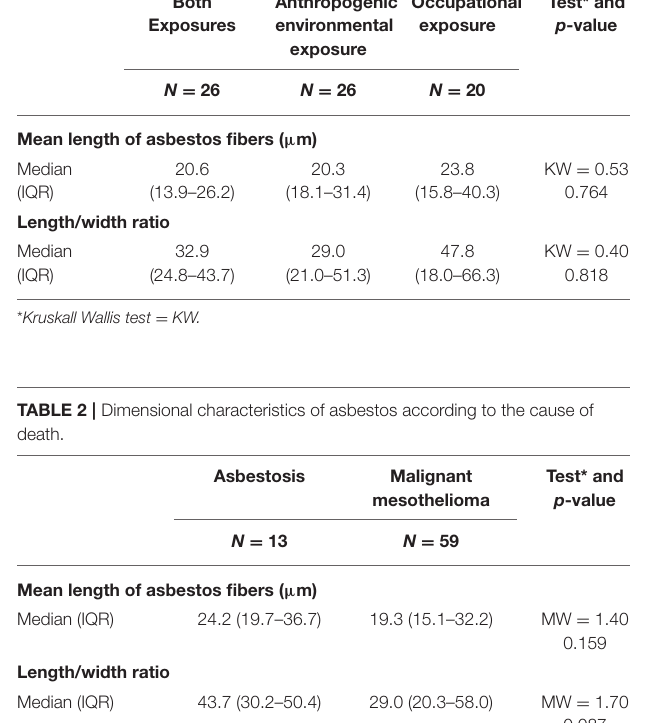
TABLE 1 | Dimensional characteristics of asbestos according to the kind of exposure. Both Anthropogenic Exposures environmental exposure